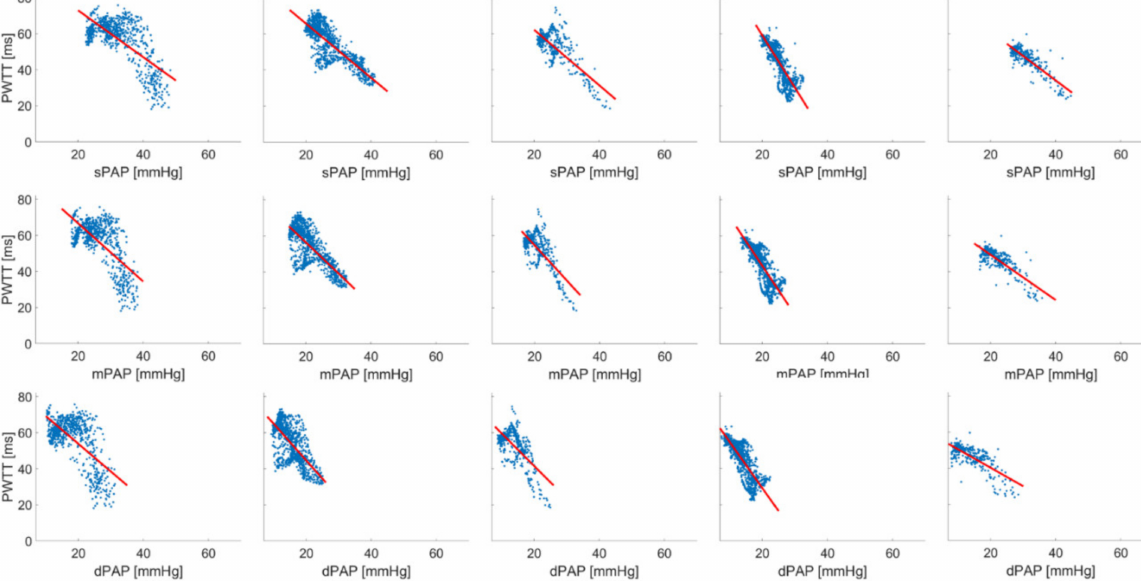
Figure 5. Inverse linear correlation between sPAP, mPAP, dPAP and PWTT during hypoxic pulmonary vasoconstriction in five pigs. Average correlation coefficient was calculated via Fisher’s-Z transformation (sPAP r = 0.809 ± 0.081 *, mPAP r = 0.778 ± 0.082 and dPAP r = 0.734 ± 0.090, *: Significant difference between sPAP vs. dPAP, p ≤ 0.05, rmANOVA). Linear regression was performed by least square